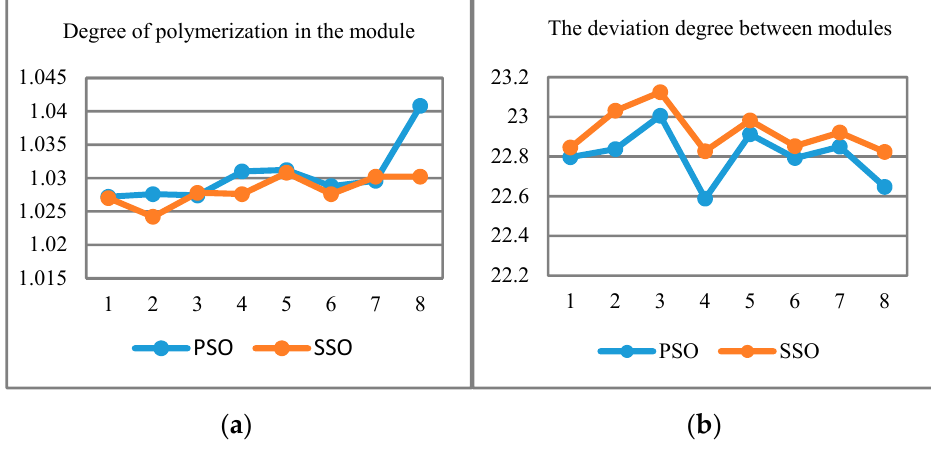
Figure 6. ( a ) Degree of polymerization in the module; ( b ) degree of deviation between modules.